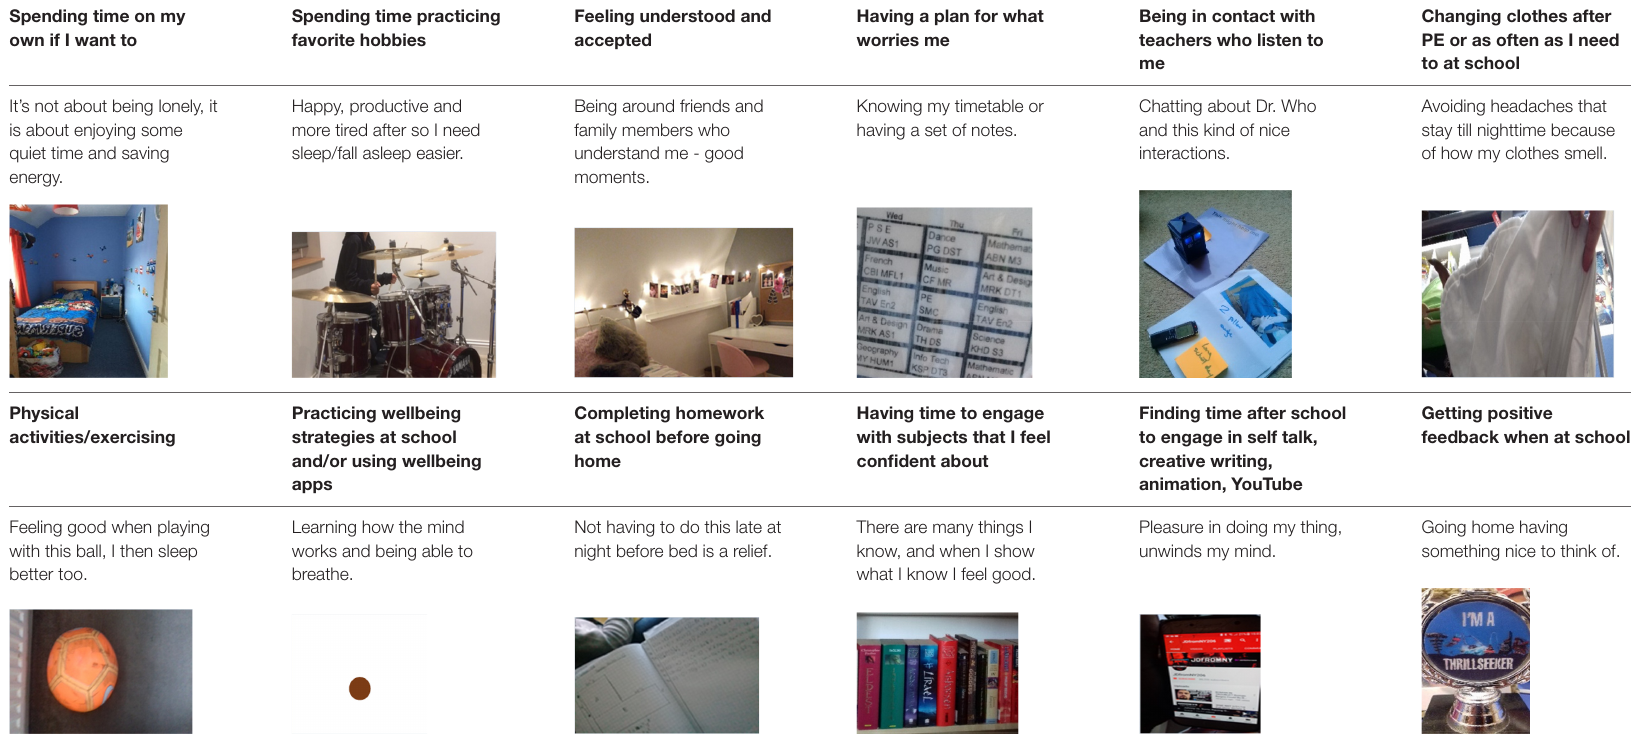
It’s not about being lonely, it is about enjoying some quiet time and saving